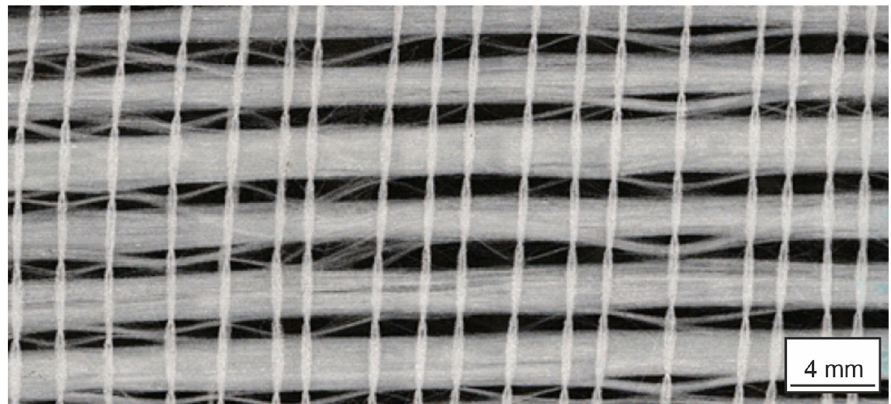
Figure 1: Image of the used non - crimp fabric.